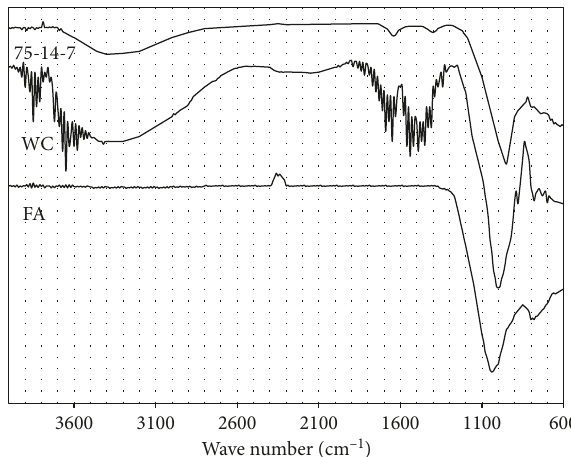
Figure 7: IR spectra of FA, WC, and the geopolymer specimen produced at 75% FA.